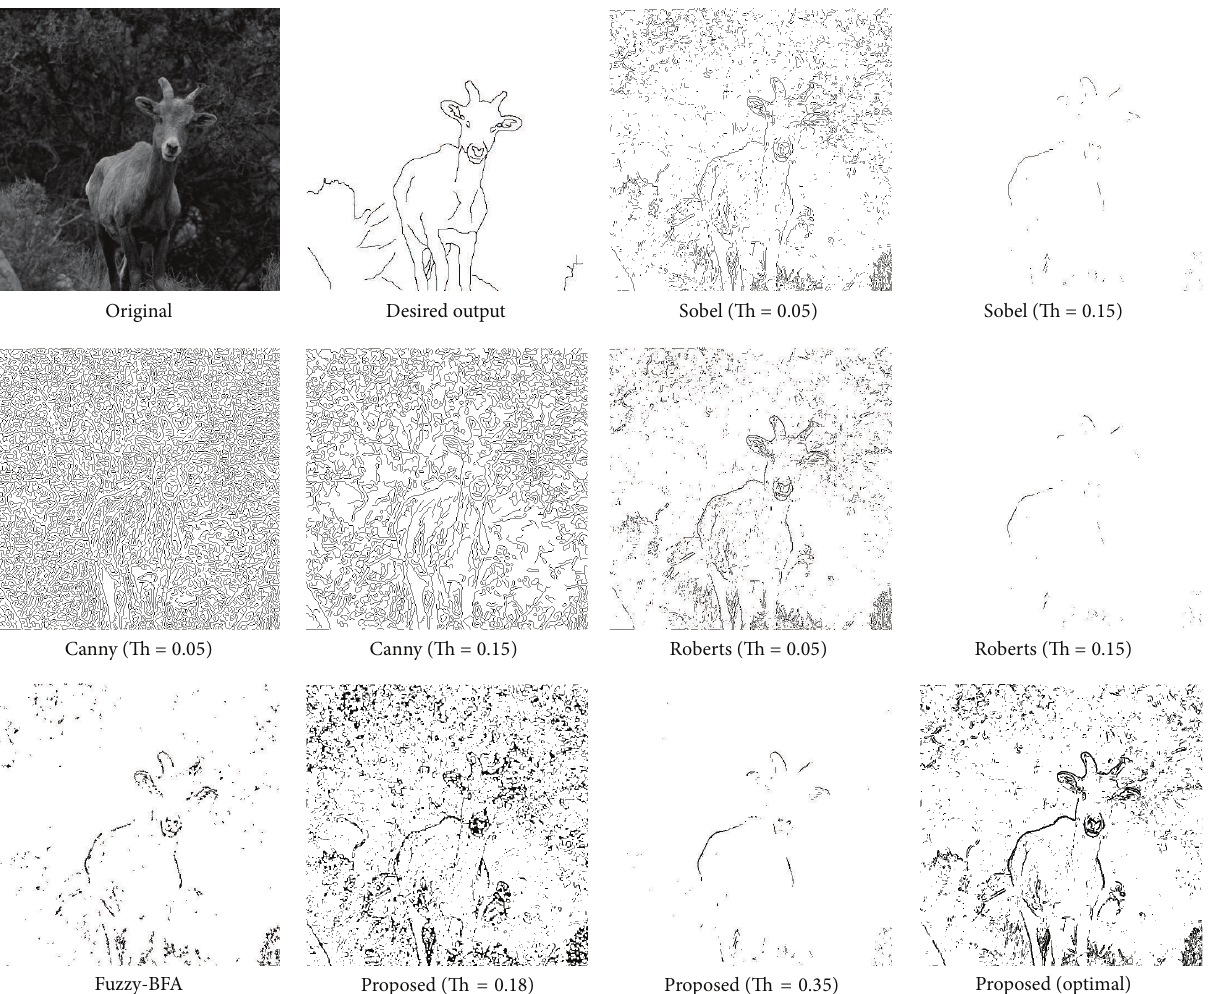
Figure 5: Edge detection results of “goat” image: desired edge output of “goat” image; Sobel, Canny’s, and Roberts methods using thresholds = 0.05 and 0.15; fuzzy-BFA method; proposed method with fixed thresholds (0.18 and 0.35) and optimal